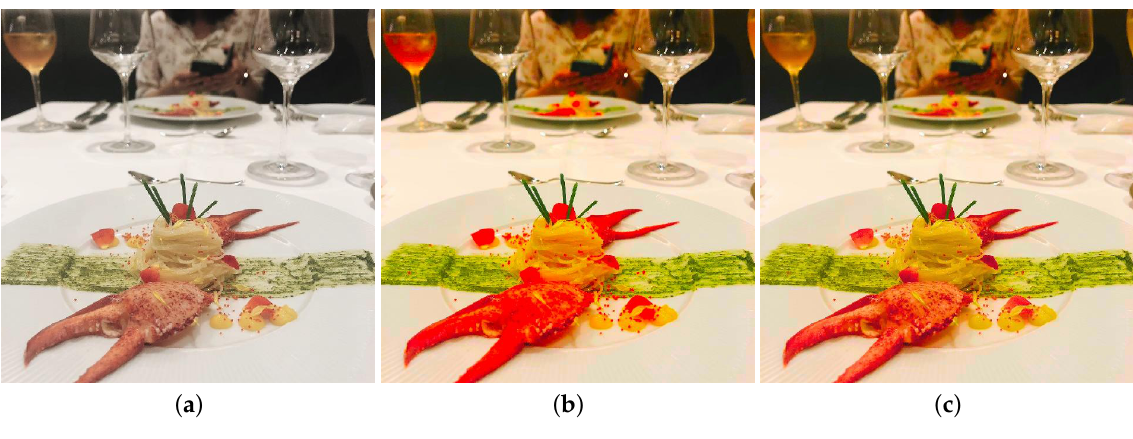
Figure 2. Experimental results. ( a ) Original image. ( b ) Resulting image applying only Equation (3). ( c ) Resulting image applying Equation (5) to ( b ).